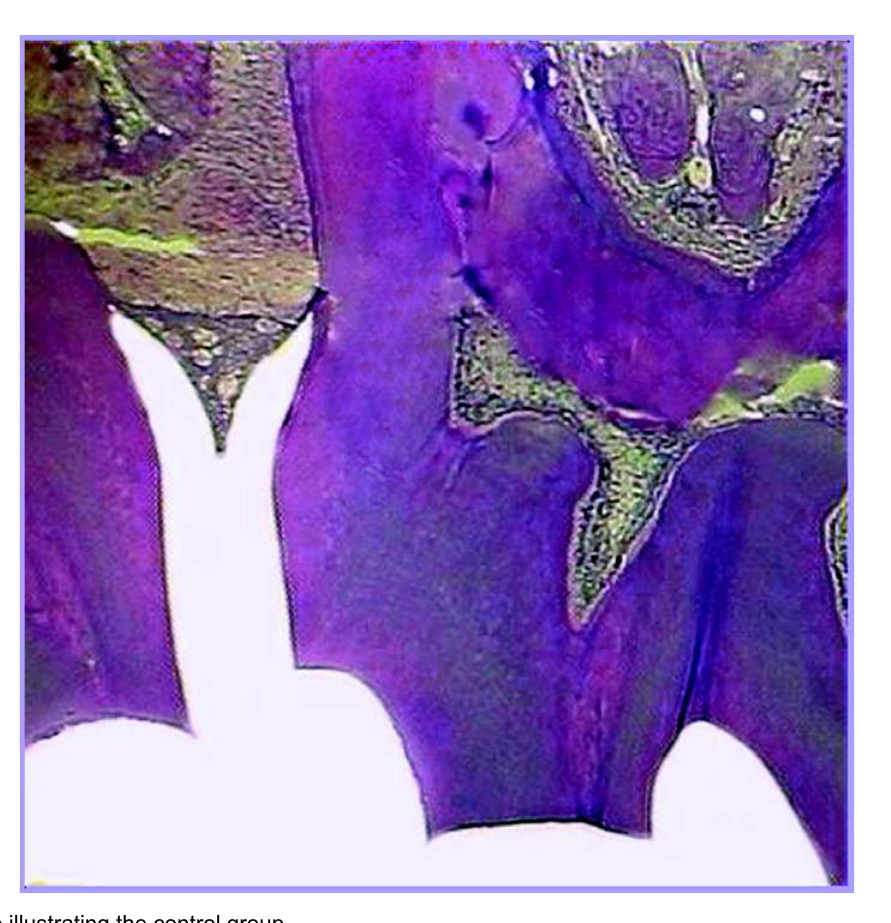
FIGURE 2- Figure illustrating the control group